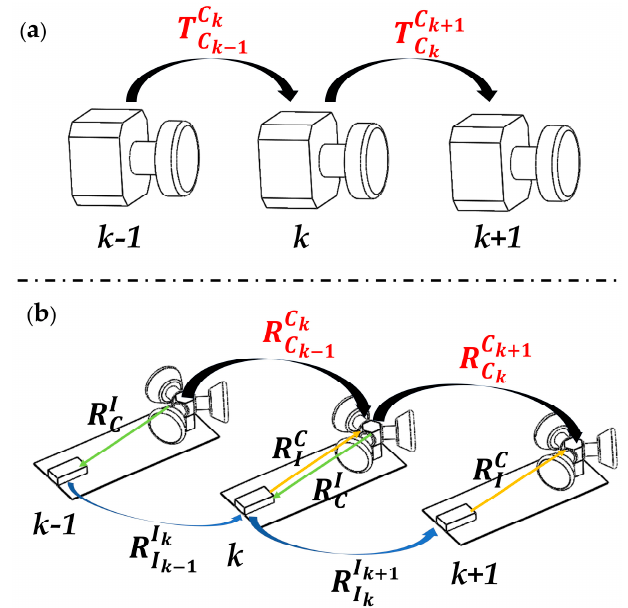
Figure 7. The different factor graphs. ( a ) factor graph of common visual odometry (VO) method; ( b ) factor graph of the proposed VINS-MKF.